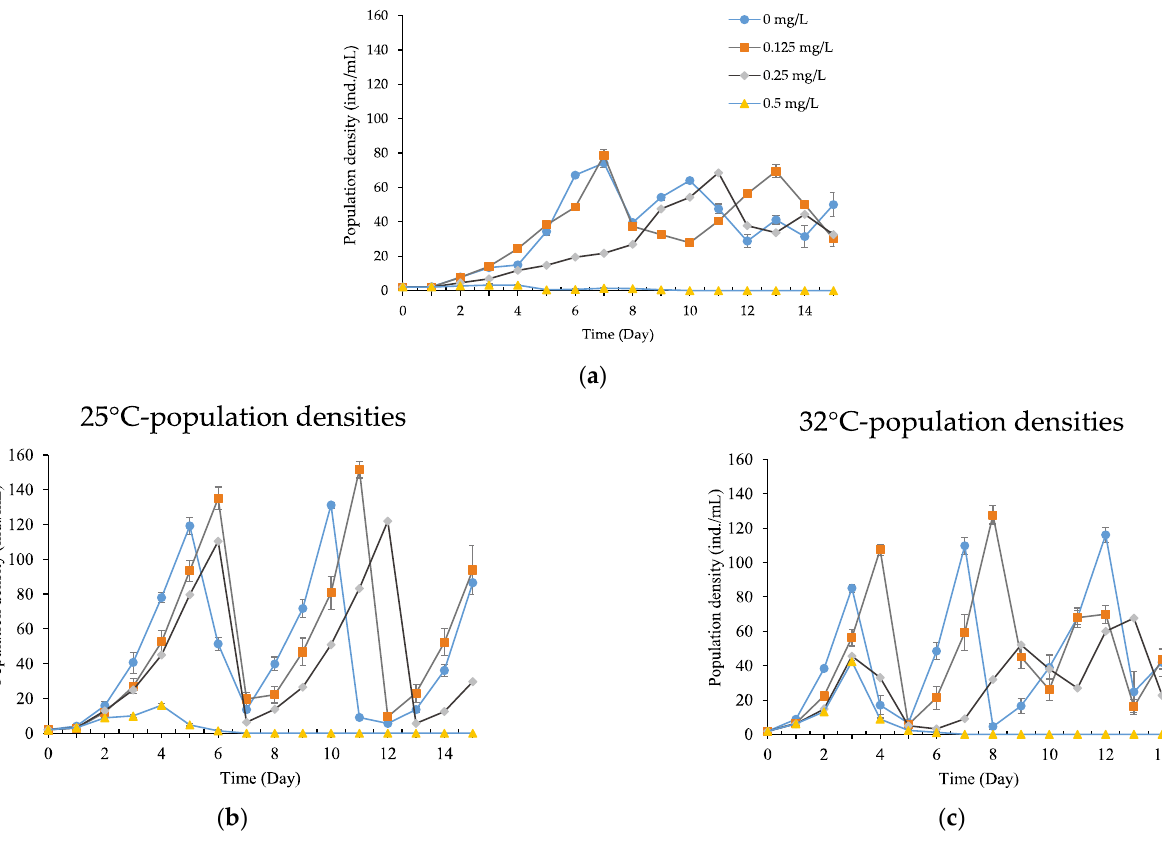
Figure 3. Population growth curves expressed by population densities of the B. calyciflorus exposed to chlorpromazine cultured at 18, 25 and 32 °C. Shown are the mean ± standard error based on three replicates for: ( a ) 18 °C—population densities; ( b ) 25 °C—population densities; ( c ) 32 °C—population densities. Table 4. Population parameters of B. calyciflorus to three concentrations of chlorpromazine at differ- ent temperatures. Shown are the mean ± standard error based on three replicates. CPZ Concen. (mg/L)